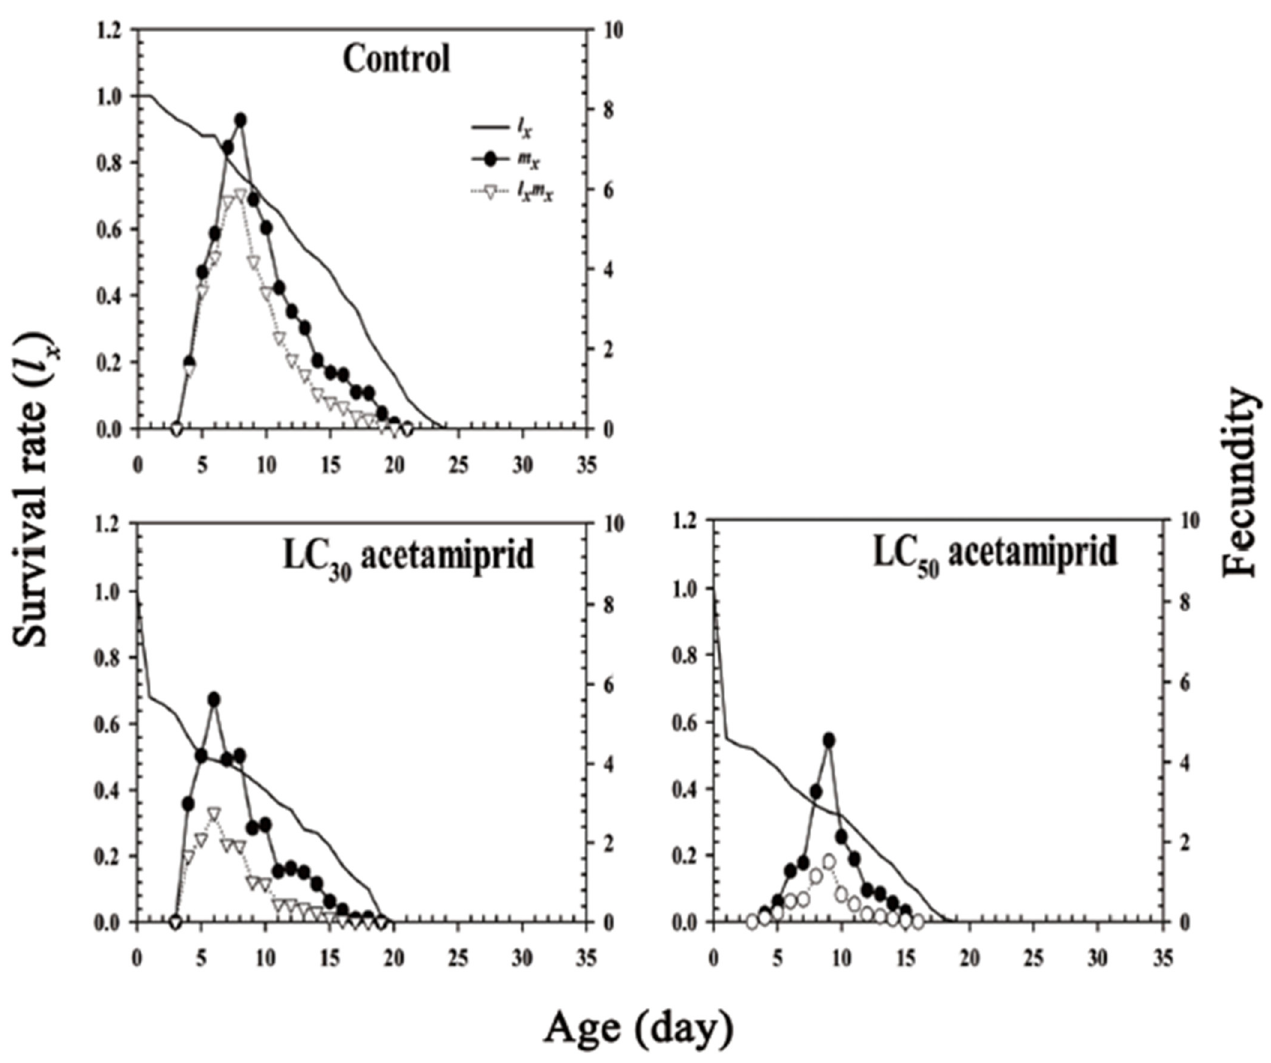
Figure 2. Age-specific survival rate ( l x ), age-specific fecundity of the total population ( m x ), and age-specific maternity ( l x m x ) of Aphis glycines.